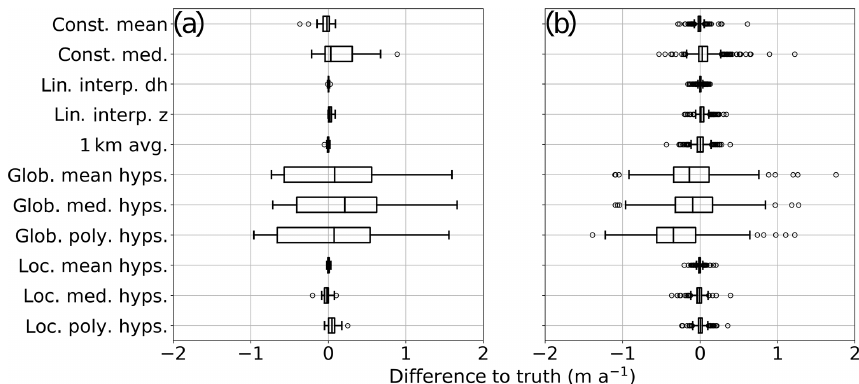
Figure 8. Difference to true volume change for each method tested for (a) glaciers larger than 100km 2 ; (b) all glaciers.